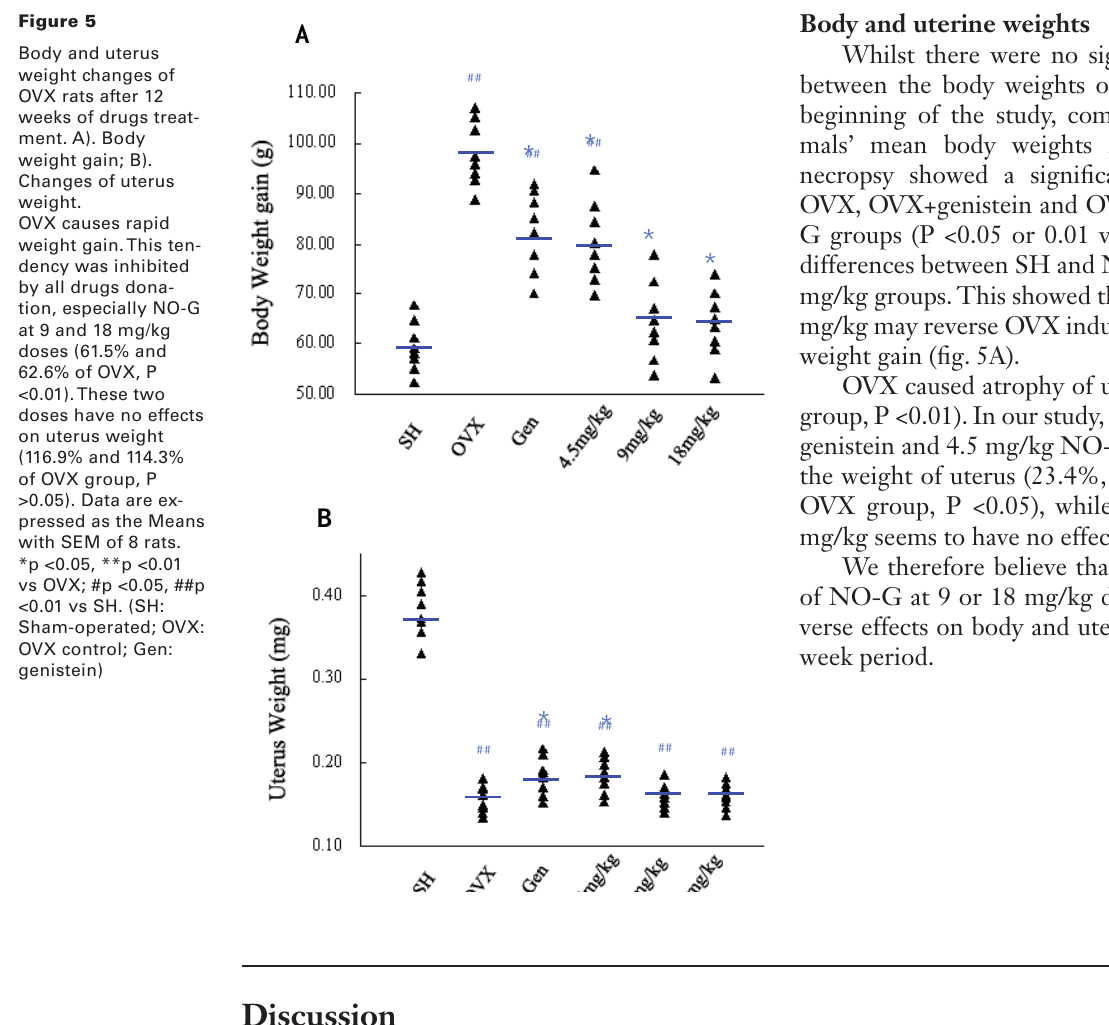
Figure 5 Body and uterus weight changes of OVX rats after 12 weeks of drugs treat- ment. A). Body weight gain; B).